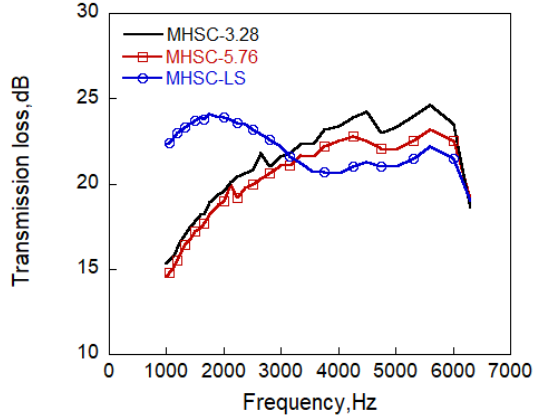
Figure 9. The sound transmission loss of the MHSCs.